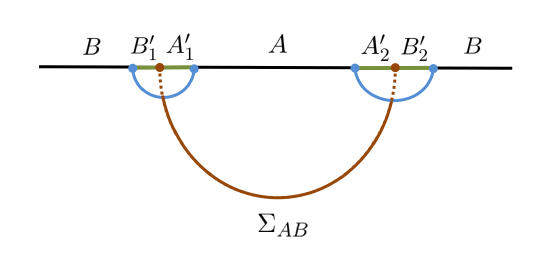
Figure 11: The extension of the EWCS Σ P and P which divide the complement of A ∪ B into A (cid:48) 1 2